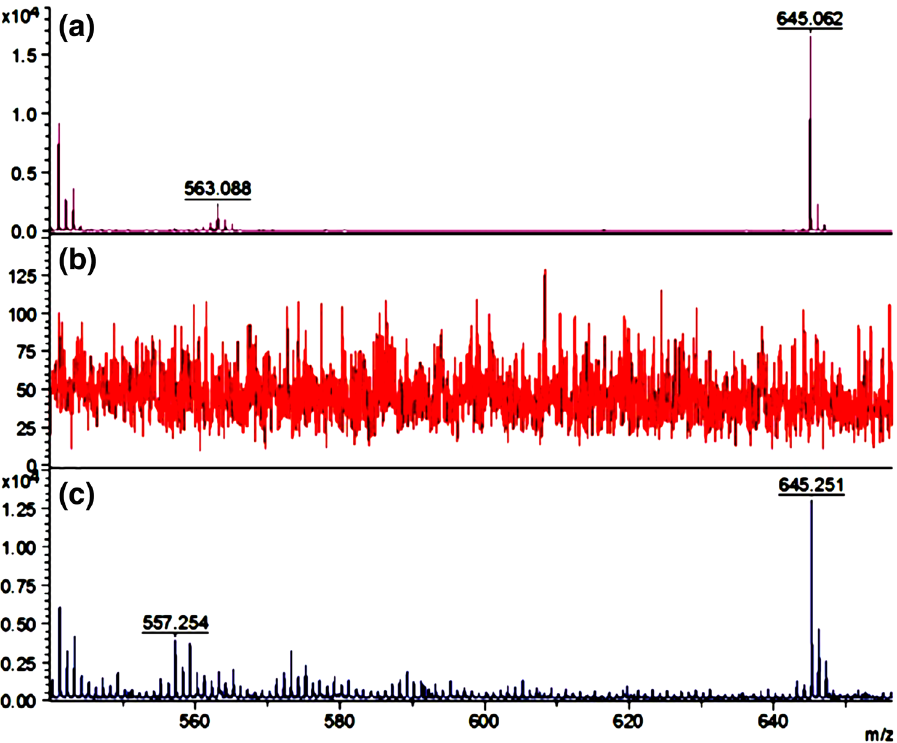
Figure 12. Comparison of average mass spectra of ( a ) AG-25 ( b ) aqueous AG-25 solution after 3 h of Fenton’s reaction over